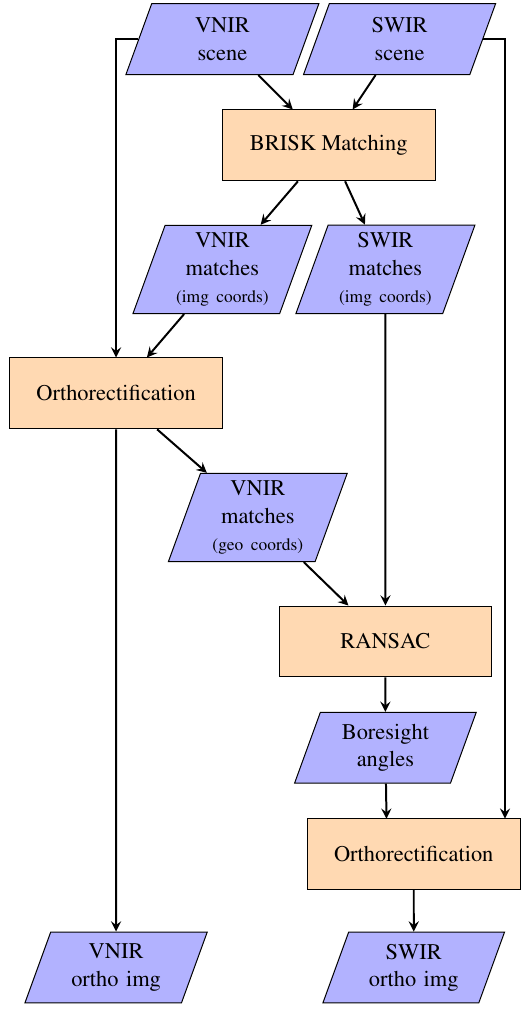
Figure 5: Methodology overview (without